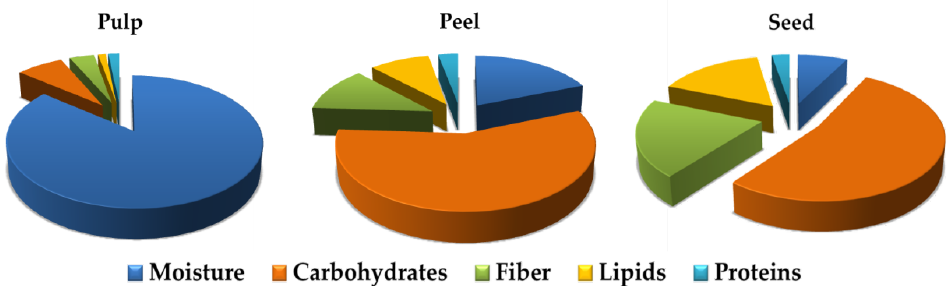
Figure 2. Nutritional composition of raw horned melon fruit [12 – 13,15,18]. Lastly, we discuss horned melon